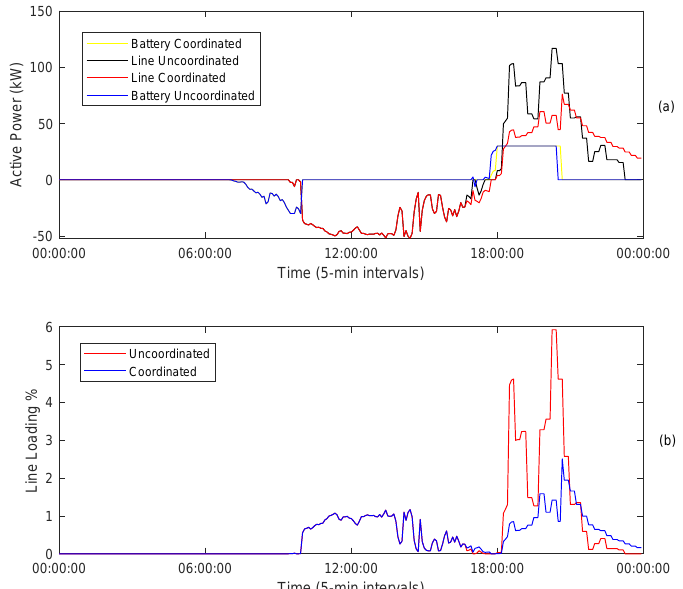
Figure 11. Total EV power ( a ), and distribution line loading ( b ) for uncoordinated charging vs. proposed DCC methods with PV and BES